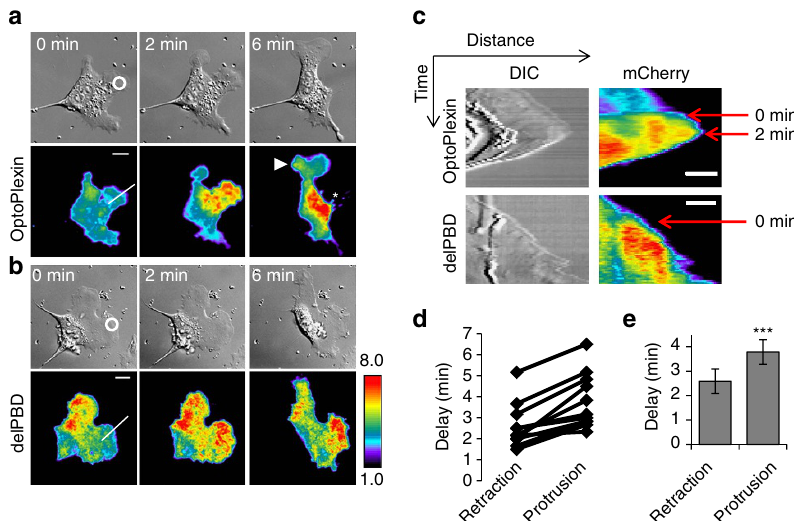
Figure 4 | OptoPlexin induces CIL upon local activation. MC3T3-E1 cells expressing mCherry-optoPlexin ( a ) or mCherry-optoPlexin-delPBD ( b ) were locally illuminated as indicated (white circle). The DIC and TIRF images were shown to illustrate the morphological changes and local membrane recruitment. Scale bar, 10 m m. Asterisk, retraction. Arrowhead, induced protrusion. ( c ) Kymographs showing cell border progression upon local activation of optoPlexin or optoPlexin-delPBD. Reference lines for the kymographs are shown in white in a , b . Scale bar, 10 m m. ( d ) Pairwise comparison of the delay in initiation of retractions and protrusions upon local optoPlexin activation. ( e ) Mean delay in initiation of local retractions and distal protrusions on local optoPlexin activation. n ¼ 11 cells, means ± s.e.m. are shown. *** P o 0.001 and * P o 0.05. NS, not significant, Student’s t